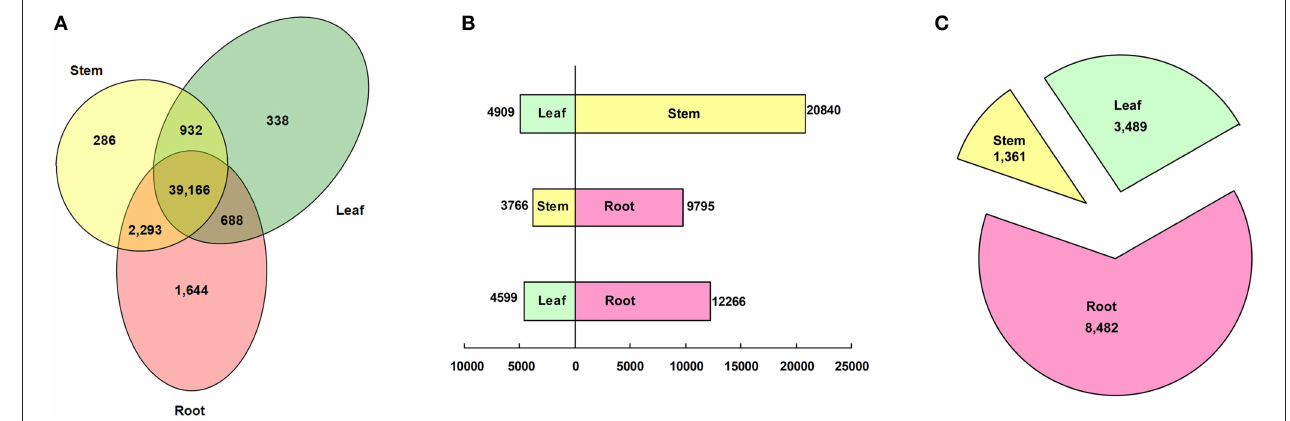
FIGURE 5 | Classification of tissue patterns. (A) Venn diagram of tissue-specific gene expression. (B) Histogram of differentially expressed genes between tissues. (C) Pie chart of genes predominantly expressed in each